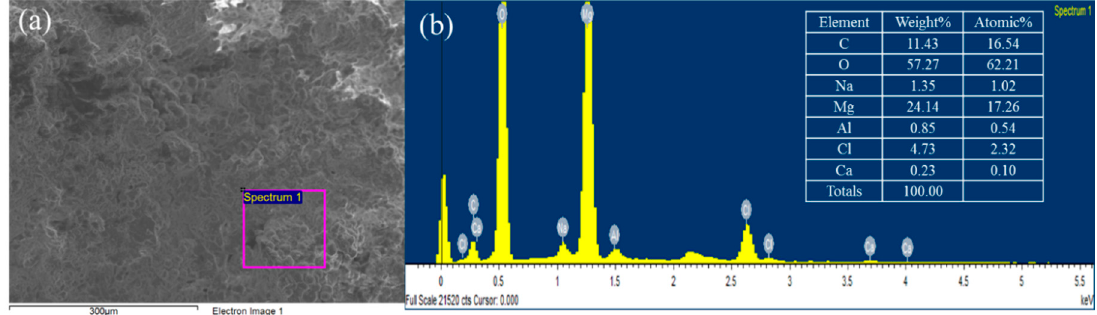
Figure 2. The FE-SEM image ( a ) and the energy dispersive X-ray (EDX) spectra ( b ) of the BP.